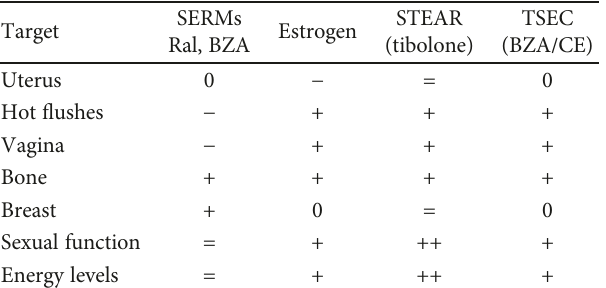
Table 1: Targeted responses to systemic menopause treatments [6 –